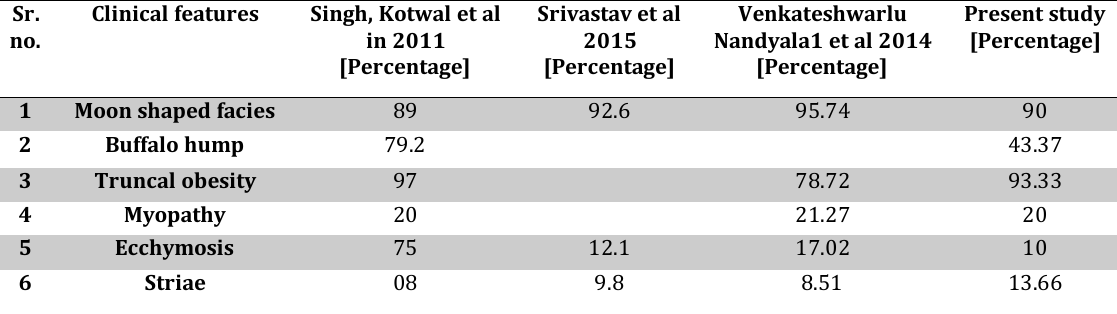
Table-5 . Comparison of Clinical features of Cushing’s syndrome with earlier studies